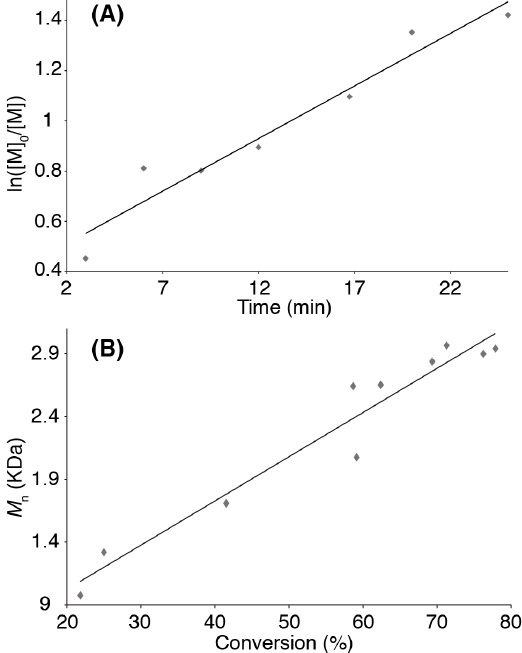
Figure 1. Kinetics plots of GRIM (Grignard metathesis) polymerization of M1: ( A ) ln([M] 0 /[M]) vs. time; and ( B ) M n vs. conversion.